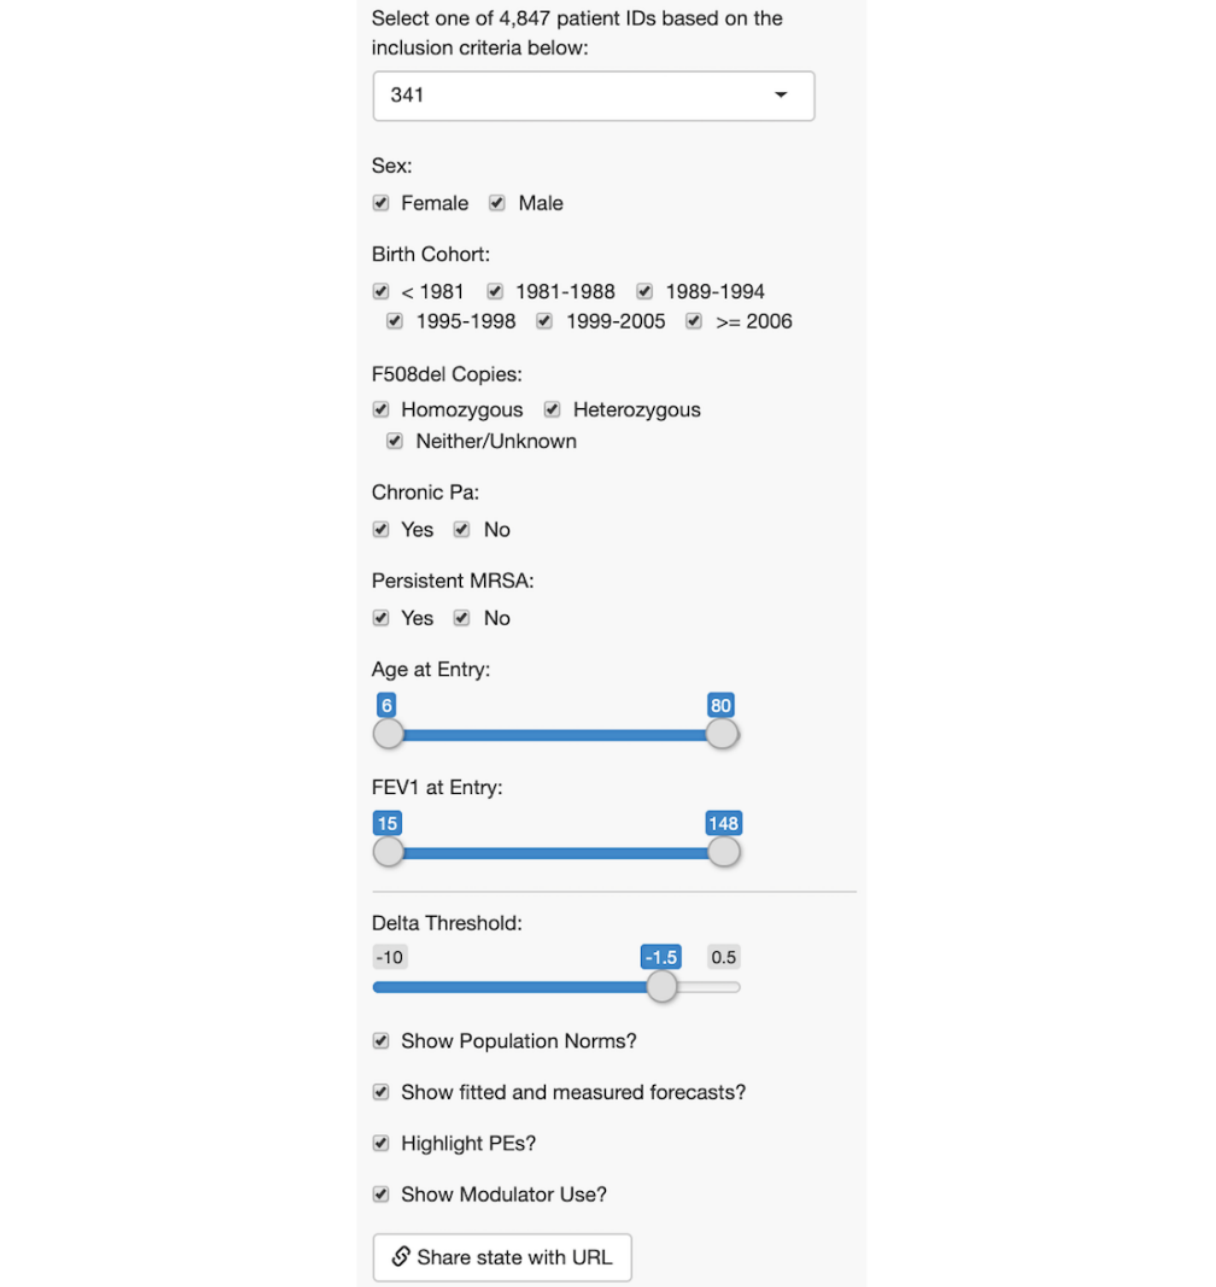
Figure 2. Leftmost panel of Cystic Fibrosis Point of Personalized Detection (CFPOPD). The drop-down menu shows patient 341 has been selected. Users can subset the patient sample by toggling options for sex, birth cohort, genotype (F508del copies), Pseudomonas aeruginosa (Pa) and Staphylococcus aureus (MRSA) infections, and forced expiratory volume in 1 second (FEV1) and age at entry into the US Cystic Fibrosis Foundation Patient